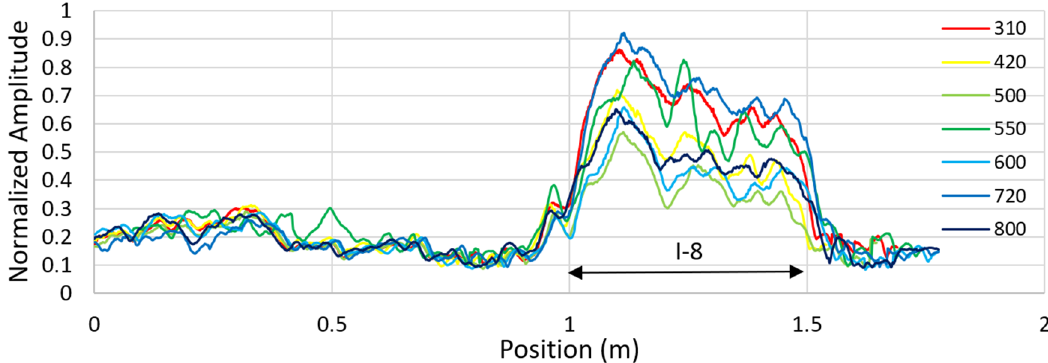
Figure 34. 2.6 GHz Normalized RW amplitudes on defect I-8, in the longitudinal direction vs. K loadings.